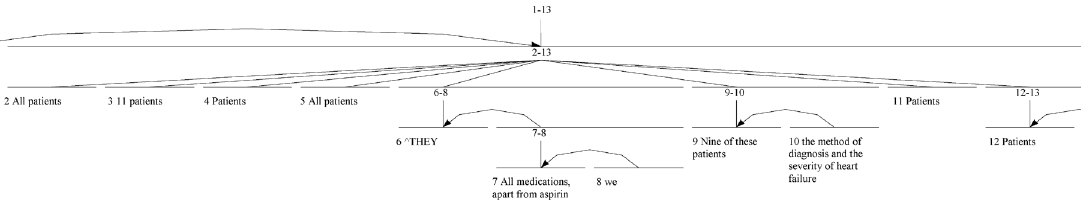
Figure 3. Theme pattern in the first subsection of Methods (elliptical Themes were recovered and written in upper case and a circumflex symbol)